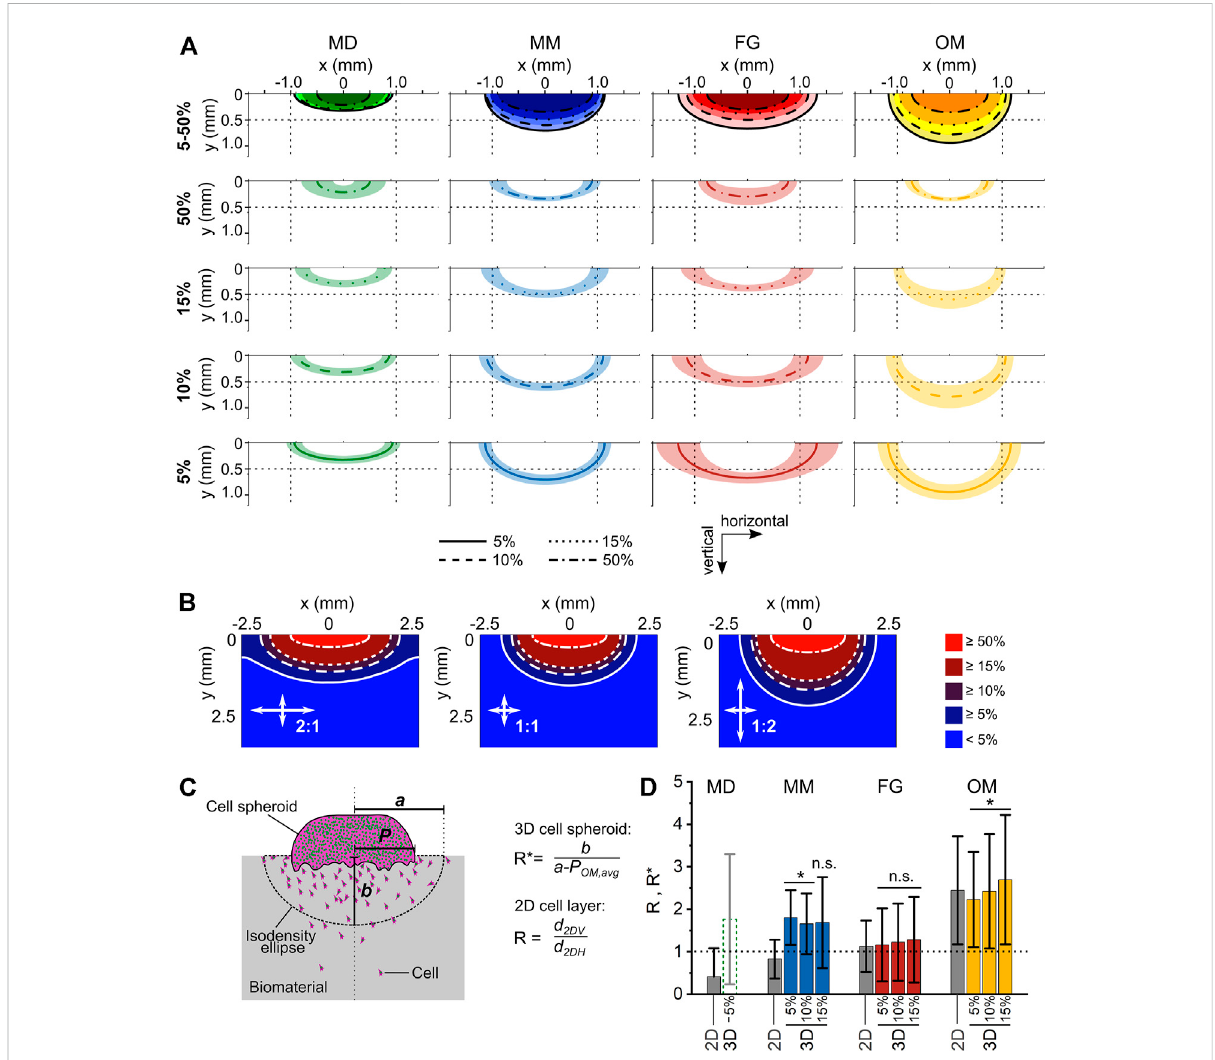
FIGURE 5 Analysis of anisotropy in cellular migration within the investigated biomaterials. (A) Isodensity ellipses for the different biomaterials analyzed at 4 cell density thresholds (5%, 10%, 15%, and 50%). The fi rst row shows the overlay of the mean isodensity ellipses for each biomaterial, while the subsequent rows show the mean values (line) ± standard deviation (shaded area) of each isodensity ellipse. To ease the comparison between the plots, reference lines are shown at 0.5 mm and ±1 mm of the vertical and horizontal coordinates, respectively; (B) Diffusion patterns obtained from computational simulations for three ratios of horizontal and vertical diffusion coef fi cients (2:1, 1:1, and 1:2); (C) schematic representation of spheroid radius ( P ), semi-major axis (a) , and semi-minor axis (b) in the 3D spheroid assay; (D) migration anisotropy in 3D spheroid assay as measured with the ratio R* and compared to the ratio R obtained in the 2D layer assay (gray bars). Results are given as mean ± standard deviation. The dotted line marks the value of an ideal isotropic migration behavior R* = 1. Statistical signi fi cance was tested for the difference between the R* values of the individual biomaterials and R* = 1 and it indicates anisotropic